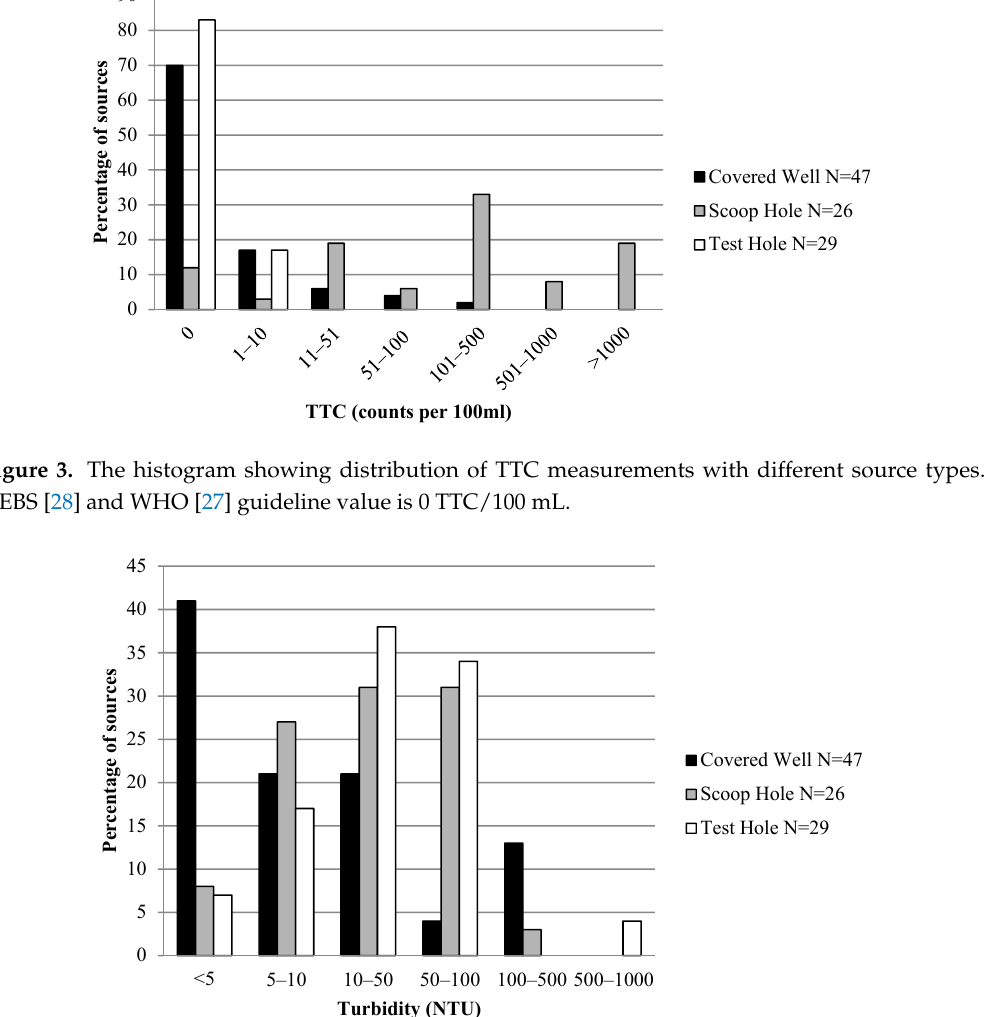
Figure 4. The histogram showing the distribution of turbidity measurements with different source types. KEBS [26] and WHO [27] guideline values are <5 NTU and <1 NTU respectively.